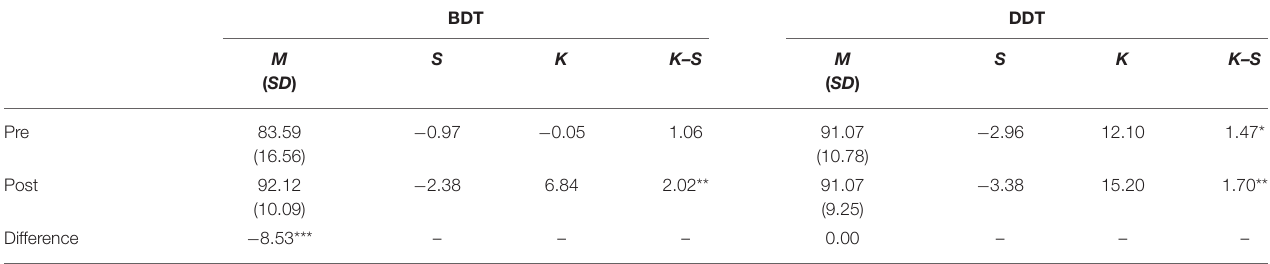
TABLE 3 | Accuracy (%) in BDT and DDT before and after the mindfulness training in the national team ( n = 41).